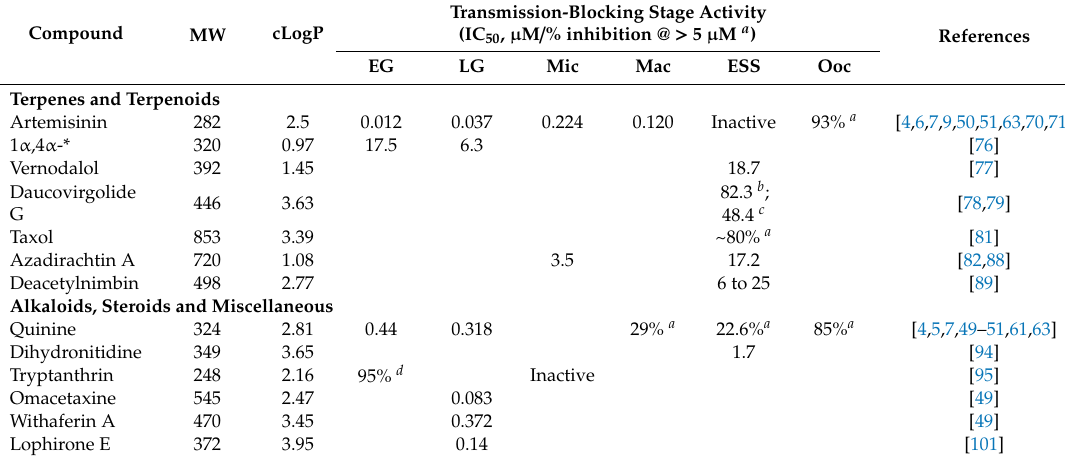
Table 2. Transmission-blocking activity of plant-derived natural product compounds. (Further details provided in Table